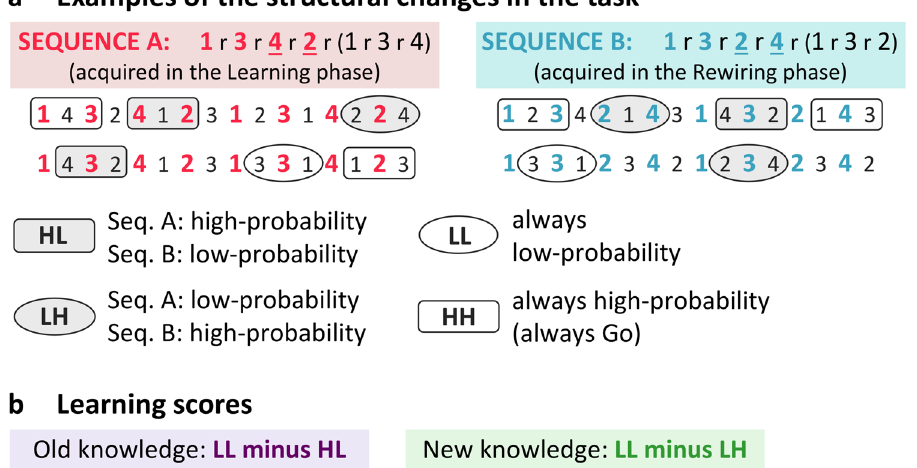
Figure 2. Task structure and measures of learning in the experiment. ( a ) Locations of the visual stimuli followed a predetermined sequential order (1 through 4 on the figure indicate the four horizontally arranged locations on the screen) that alternated with randomly chosen locations (indicated by r) out of the four possible ones. Example sequences are shown on the figure; overall, pairs of six unique sequences were used in a counterbalanced order. Due to the alternating sequence structure, some runs of three consecutive trials were more probable than others (referred to as high- vs. low-probability triplets, respectively) 29 . An example of the difference between Sequence A and Sequence B used in the Learning and Rewiring phases, respectively, is shown by the underlined numbers. Due to this structural change in the task, the probability of some triplets changed from the Learning phase to the Rewiring phase: 75% of the initially high-probability triplets became low-probability (HL trials; thus, the first letter refers to the triplet probability in Sequence A, while the second letter refers to the probability of the same triplet in Sequence B) and were replaced by new high-probability triplets that were initially low-probability (LH trials). Additionally, the occurrence probability of some triplets remained constant: either being low-probability (LL trials) or high-probability (HH trials) in both phases (for further details see “Methods” section). ( b ) Learning scores were calculated as differences in response times to trials with changed (LH or HL) versus unchanged occurrence probabilities (LL or HH). This enabled us to assess how participants initially acquired the associations of Sequence A, and then updated their knowledge when